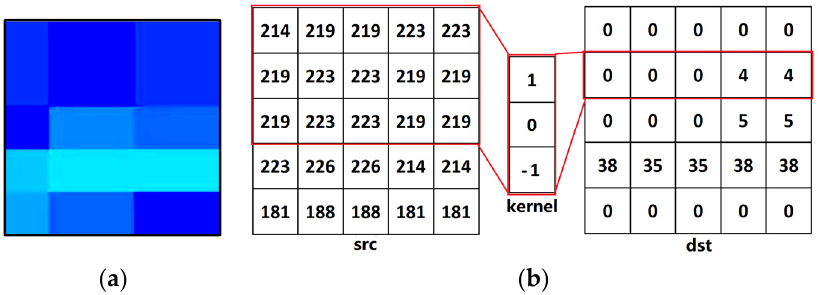
Figure 3. Convolution operation: ( a ) spectrogram; ( b ) convolution operation.